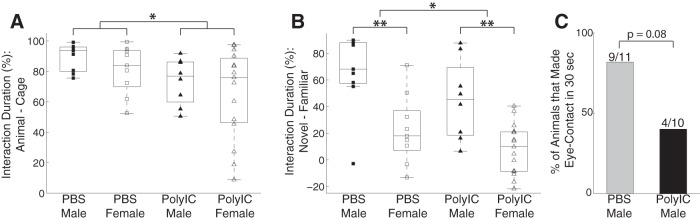

Effects of MIA on social behaviors in the ferret. A, Social interaction defined as the percentage of the time interacting with a cage with another ferret minus the time interacting with an empty cage. B, Social preference defined as the percentage of time interacting with a novel ferret minus the time interacting with a familiar ferret. Squares represent PBS group, and triangles represent PolyIC group; filled markers represent males and empty markers represent females. The central mark in the box plot indicates the median, and the bottom and top edges indicate 25th and 75th percentiles, respectively. C, Percentage of animals that made eye-contacts with an experimenter within 30 seconds. *p < 0.05. **p < 0.01.